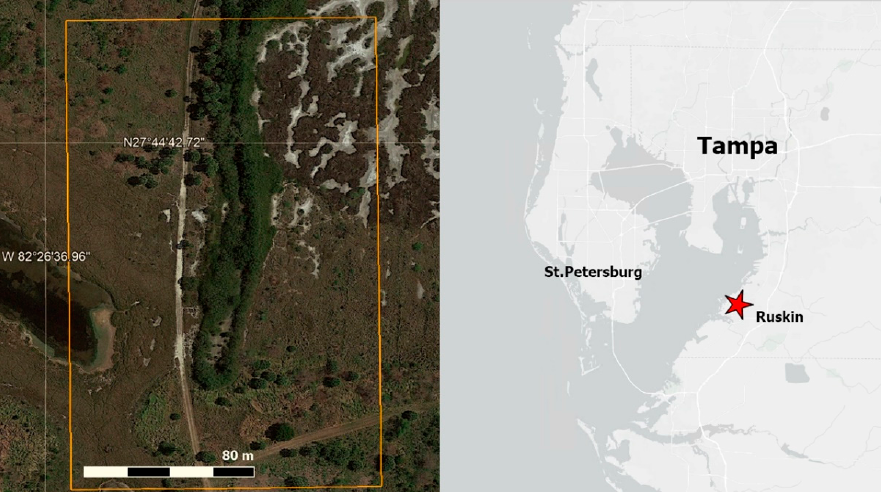
Remote Sens. 2022 , 14 , 3937 Figure 2. Study site, located at Wolf Branch creek coastal nature preserve in West Florida.